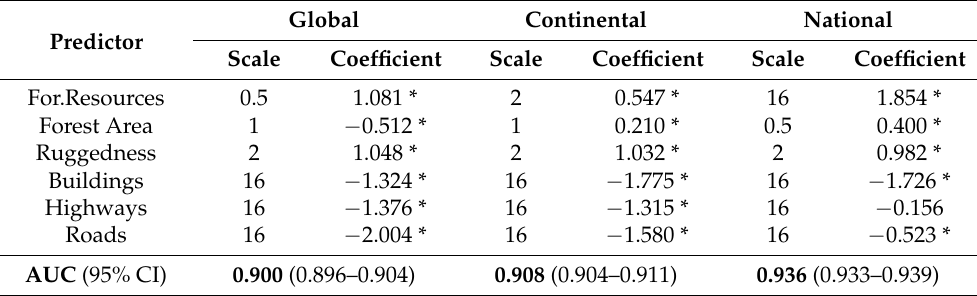
Table 2. Habitat suitability models for the three datasets resulting from different data sources used to calculate vegetation variables (i.e., foraging resources and forest area). Note that human pressure and terrain ruggedness variables are constant in the three models. “Scale” is the operational scale (km) for each environmental variable and data source. Significance levels: * <0.001. See Figures A1–A3 for the layers of the operational scales of the variables. Global Continental National Predictor Scale Coefficient Scale Coefficient Scale Coefficient For.Resources 0.5 1.081 * 2 0.547 * 16 1.854 * Forest Area 1 − 0.512 * 0.210 * 0.400 * Ruggedness 2